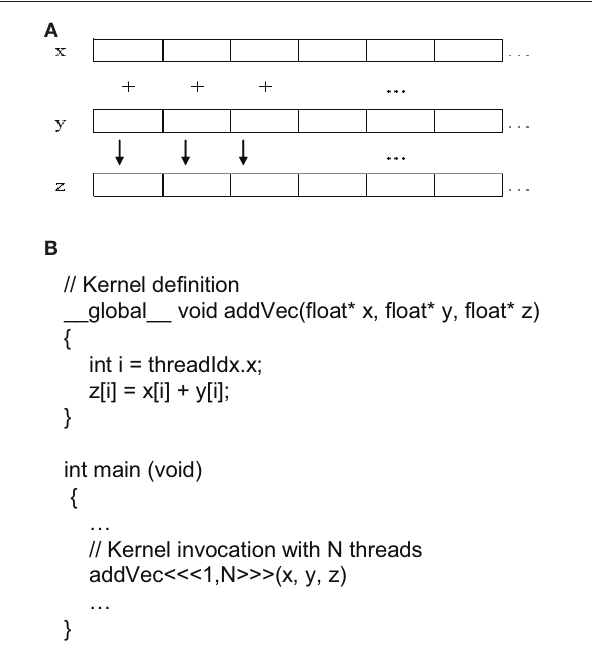
FiGure 8 | illustration of GPu-enabled parallel computing: (A) graphic representation of summing two vector x and y into vector z ; (B) CuDA C code (partial) for summing two